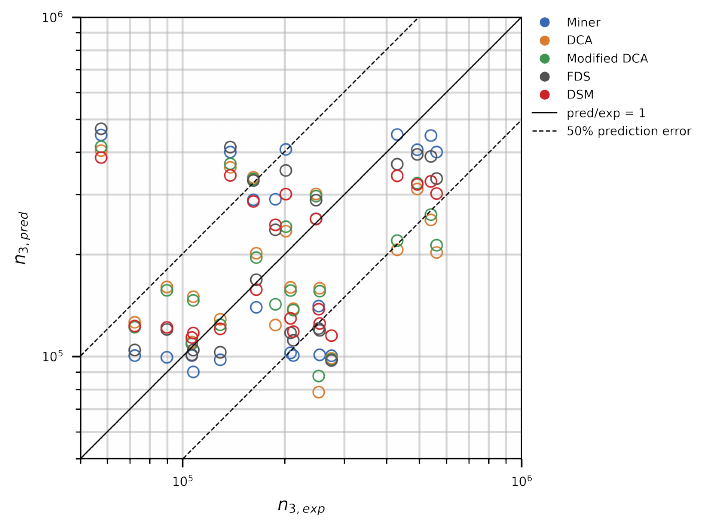
Figure 9. Predicted versus experimental remaining fatigue life for the third loading